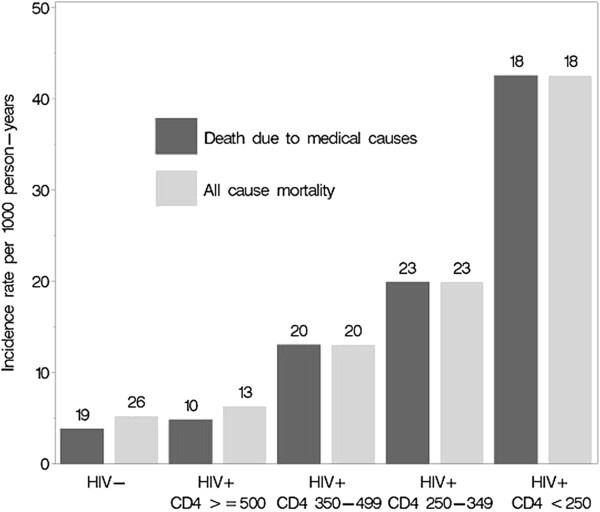
Incidence of death by HIV-1 status and CD4 category for HIV-1-infected partners. Numbers above bars indicate the absolute number of deaths that occurred in each category